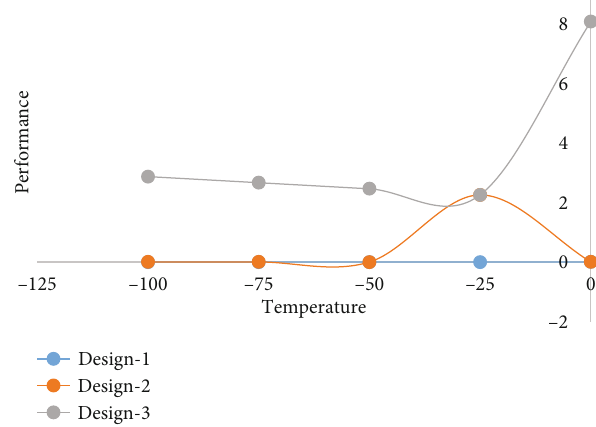
Figure 32: Operational zones vs. propeller e ffi ciency.